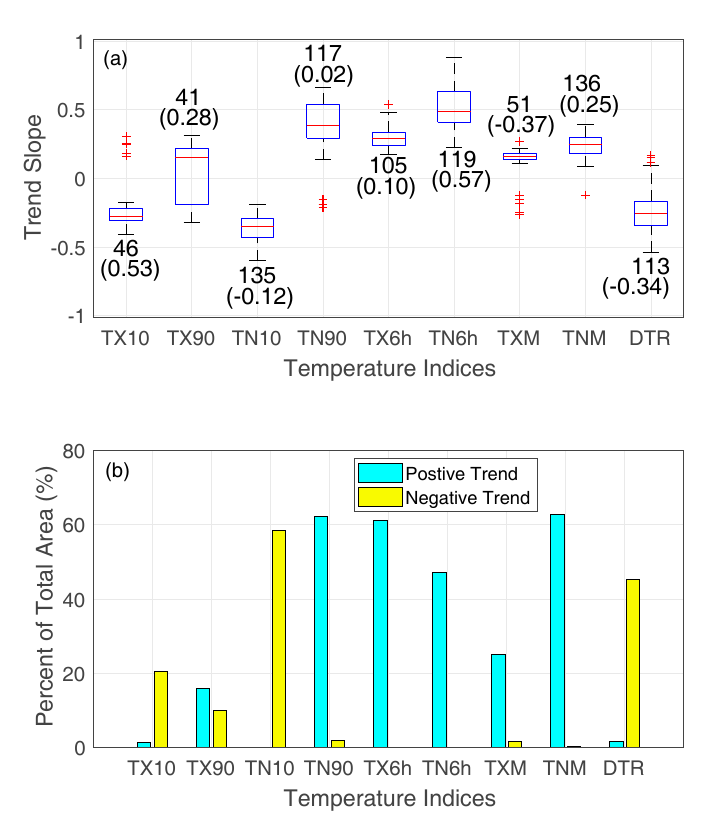
Figure 3. ( a ) Slope of significant trend of temperature indices at basin-scale in the study period 1949–2010. The unit of the slope for the first four indices (TX10, TX90, TN10 and TN90) is days/year; for other indices, the unit is °C/decade. The numbers in parentheses represent the correlation values between the slope and basin elevation; the numbers above these correlation values designate the sample size (i.e., number of basins showing significant trends). ( b ) Aggregated area of basins showing negative or positive trends over the total area of all 176 study basins.